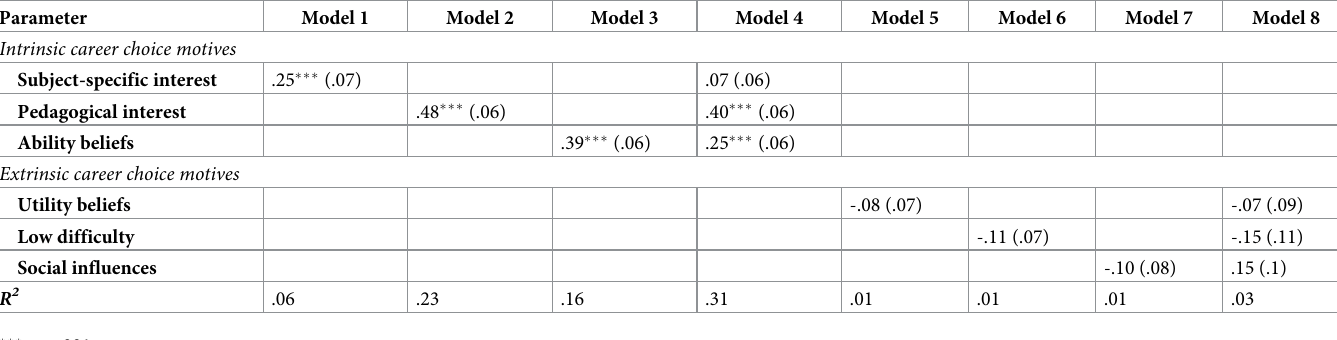
Table 4. Results of the regression analysis for the relationships between enthusiasm for teaching and indicated career choice motives (standardized regression coef- ficients; standard errors in parenthesis).